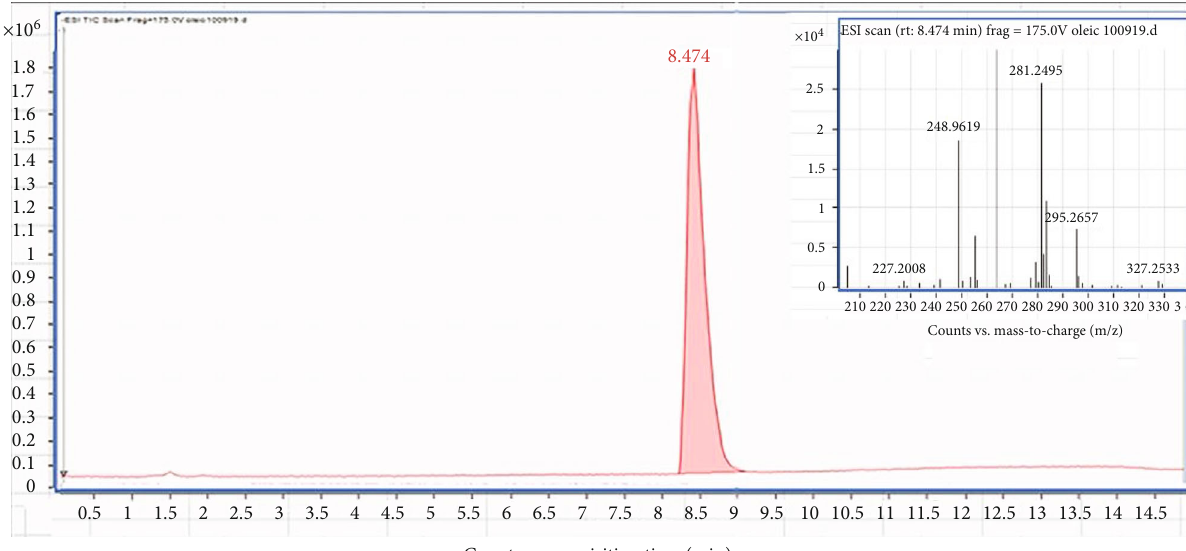
Figure 1: Representative ESI TIC peak and corresponding mass spectra (inset image) of standard oleic acid (C18:1) showing characteristic m/ z value (281.249) and retention time (8.47